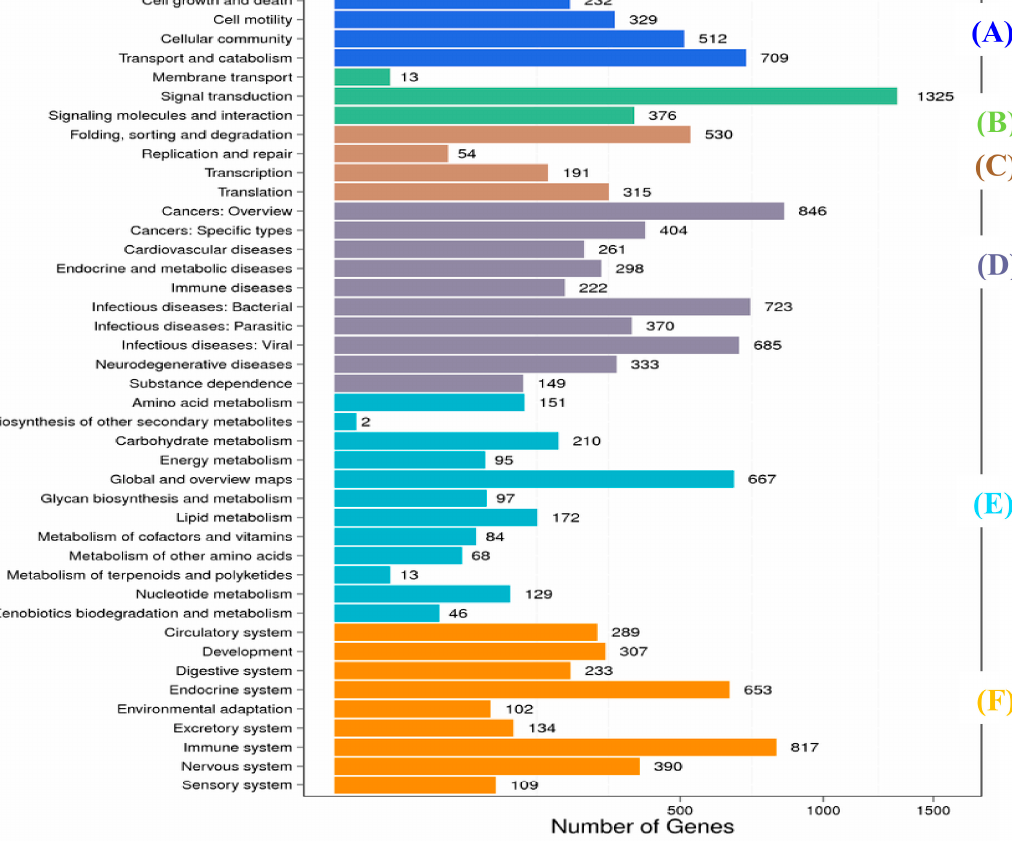
Figure 2. KEGG (Kyoto Encyclopedia of Genes and Genomes) classifications of DEGs (differentially expressed genes) in muscle. ( A ) Cellular processes; ( B ) environmental information processing organismal systems; ( C ) genetic information processing metabolism; ( D ) human diseases; ( E ) metabolism and ( F ) organismal systems.